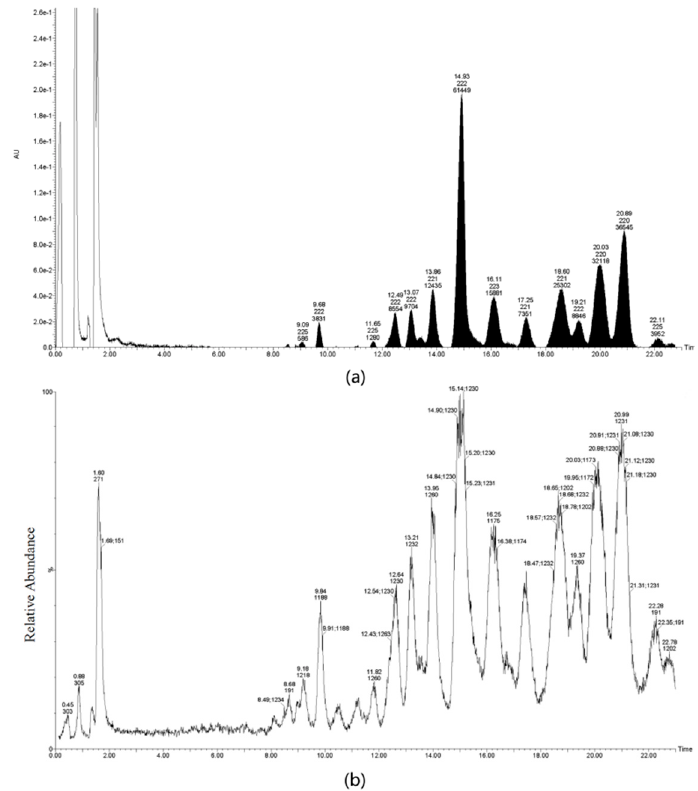
Figure 6. UPLC-MS analysis of TS isolated from green tea seeds. ( a ) Base peak intensity chromatogram at 210 nm; ( b ) Base peak intensity chromatogram at m / z 100–2000.